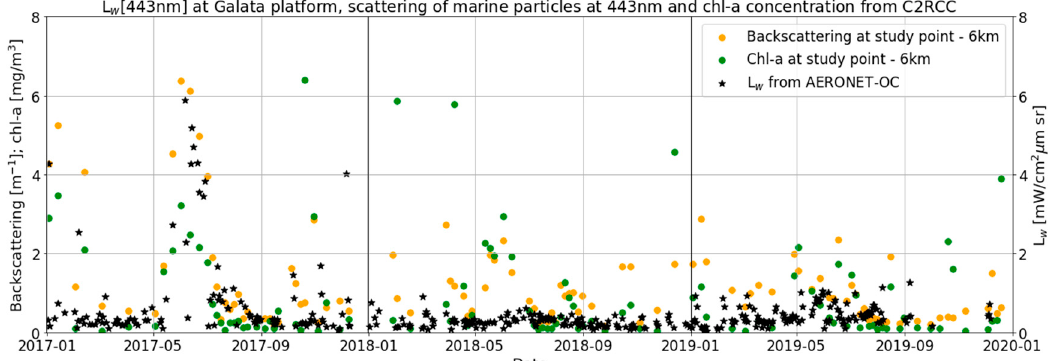
Figure 4. Water-leaving radiance at 443 nm at Galata AERONET-OC site (black stars), chlorophyll-a concentration (green dots) and scattering of marine particles at 443 nm (yellow dots) calculated with C2RCC.